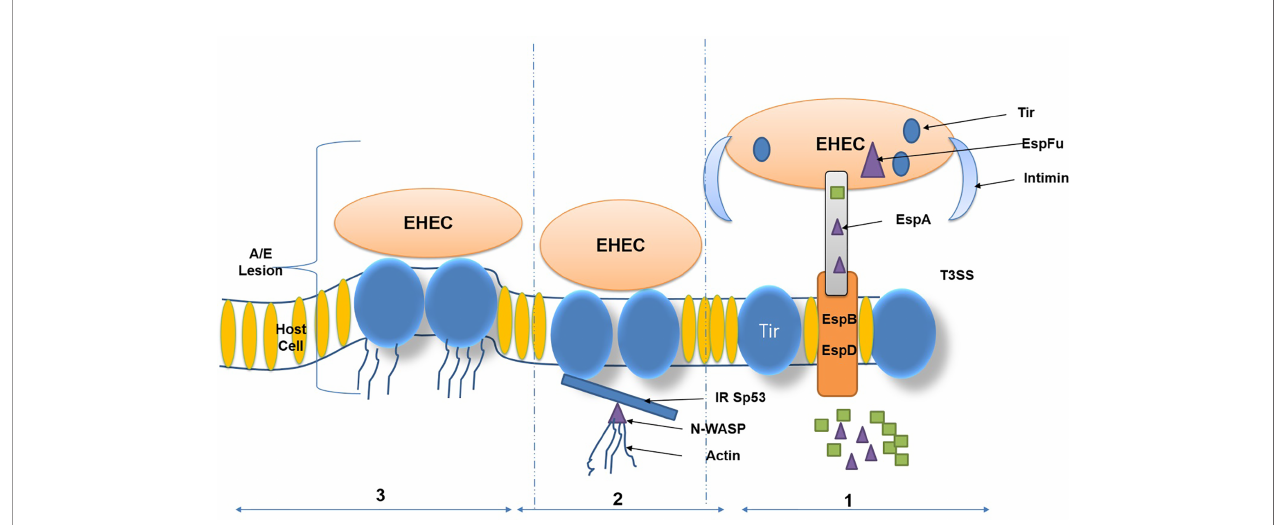
FIGURE 2 | Virulence factors and attaching and effacing (A/E) lesions of Enterohemorrhagic Escherichia coli (EHEC). (Copyright obtained from Saeedi et al.,